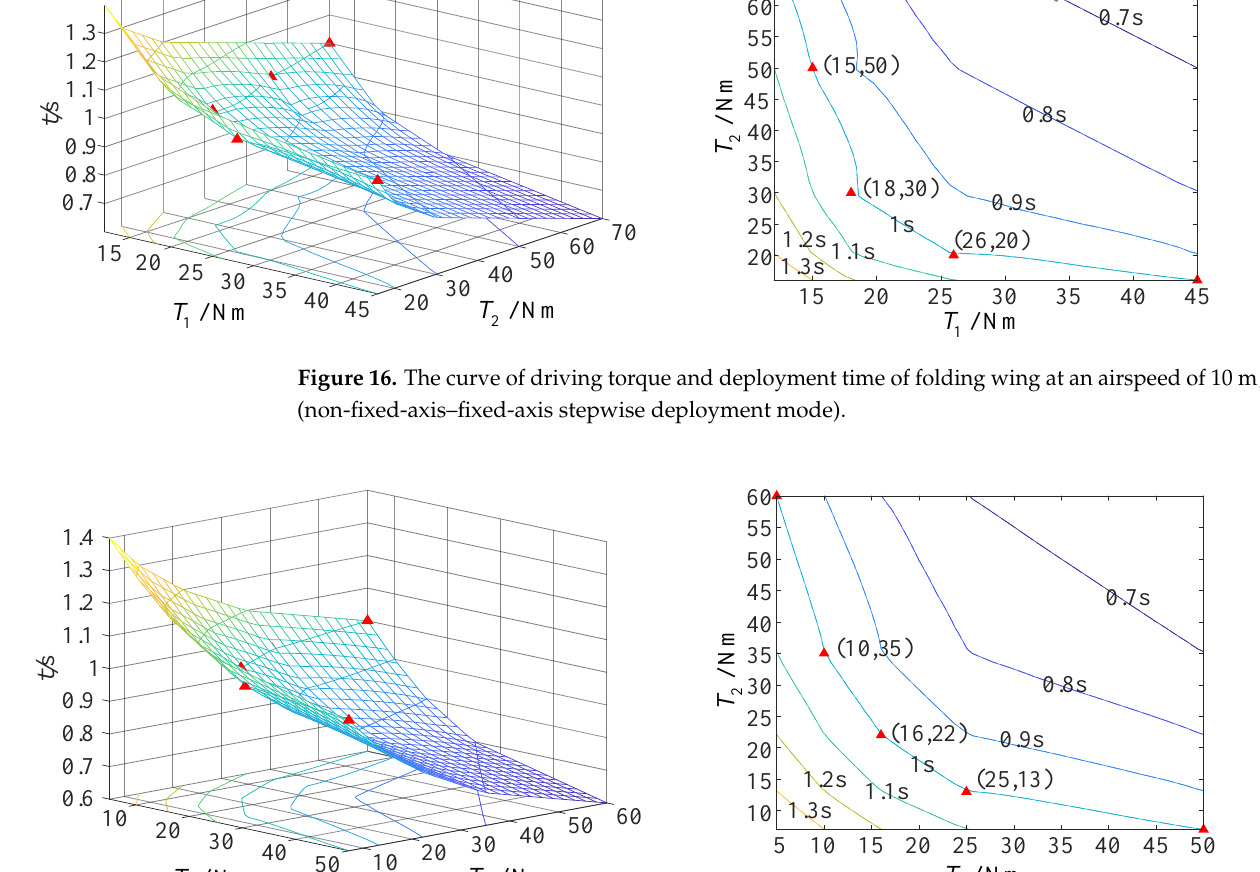
Figure 17. The curve of driving torque and deployment time of folding wing at an airspeed of 20 m/s (non-fixed-axis – fixed-axis stepwise deployment mode).